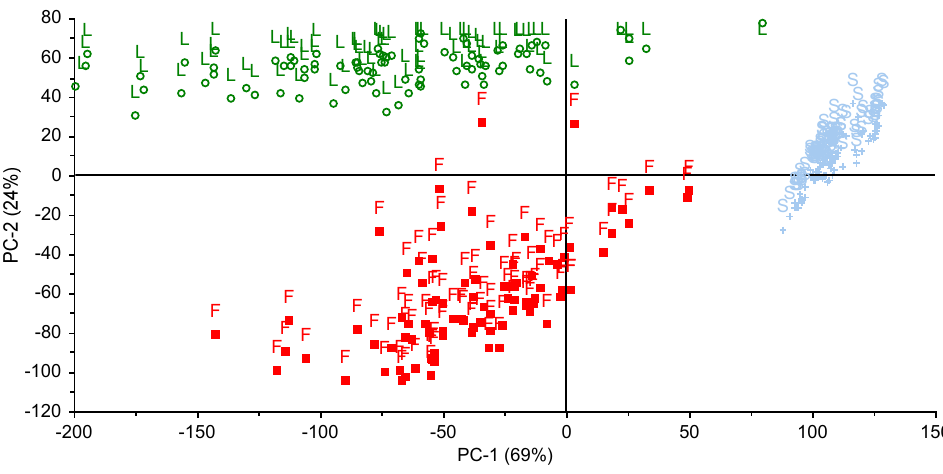
Figure 3. Principal component analysis scores plot of showing PC1 (principal component 1) vs. PC2 using spectra from 600 to 800 nm. ▪ and F, fecal matter on leaf; + and S, soil on leaf; o and L, uncontaminated leaf.